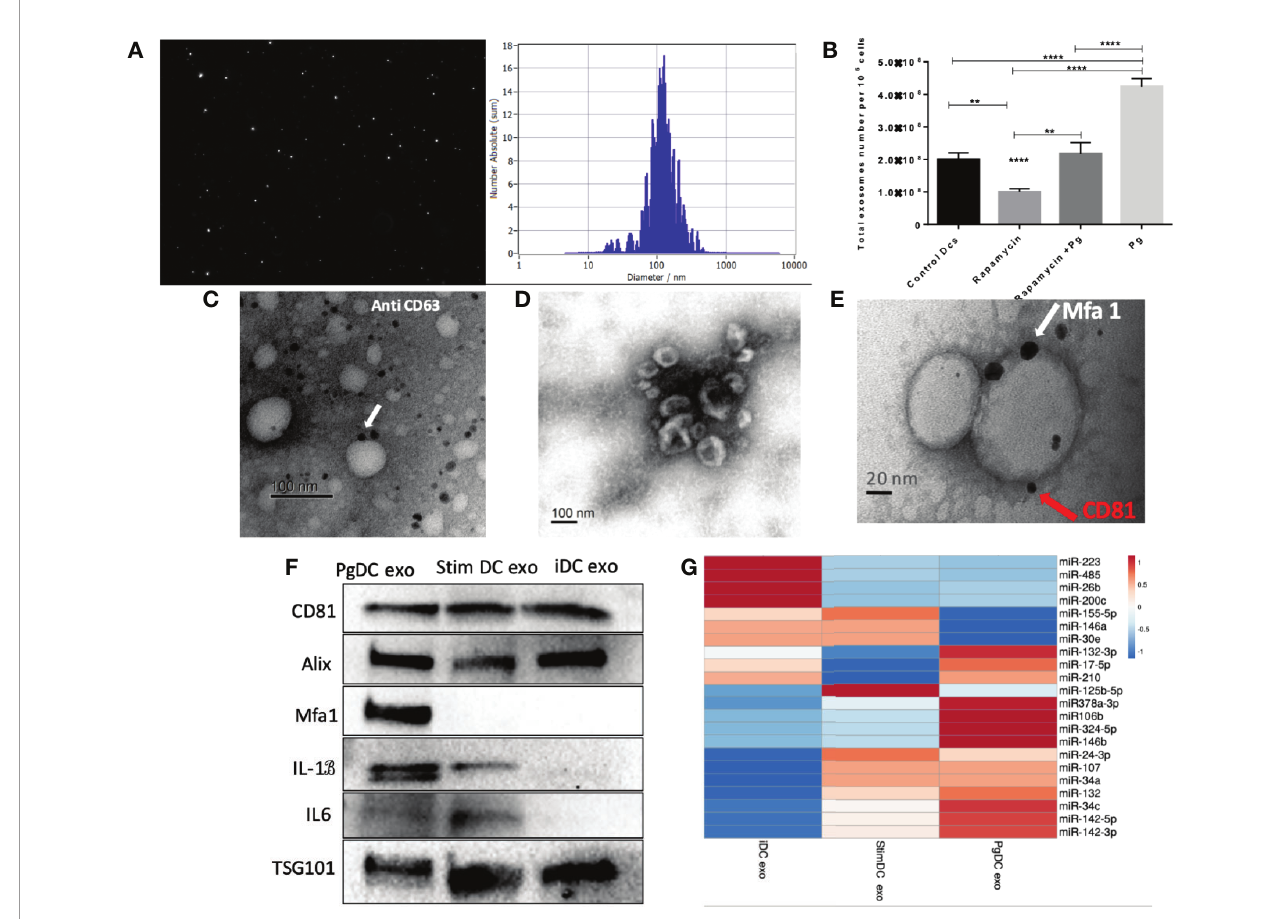
FIGURE 4 | Characterization of exosomes released from DCs infected with P.gingivalis (PgDCexo): (A) Nano tracking analysis (NTA) to determine Exo number and size distribution in nanometer (nm). (B) Total number of Exo released per 10 6 cells as determined by NTA from DCs treated or non-treated with Pg and/or Rapamycin (C) Immuno-gold TEM showing EXO marker, tetraspanin CD63. (D) SEM showing characteristic Exo morphology. (E) Co-localization of Mfa1 bacterial protein (large- sized gold Nano particle indicated with white arrow) with the eukaryotic cellular exosomal marker, CD81 (small-sized gold Nano particle indicated with red arrow) using TEM immune-gold double labeling (F) Western blot showing Exo-related markers TSG101, Alix, and tetraspanin CD81 and proin fl ammatory cytokines IL6, TNFa and IL-1b and Mfa1 in exosomes released from control immature DCs (iDCs), Ecoli LPS-stimulated mature DCs (StimDCexo) and Pg infected DCs (PgDCexo). (G) miRNA analysis of Pg or Ecoli LPS-induced DCs Exo (PgDC exo and StimDCexo respectively) compared to immature control DCs exo; (iDCexo). (iDCs), control immature DCs exo, (StimDCexo), Ecoli LPS-stimulated mature DCs exo; (PgDCexo), Pg-infected DCs. **p<0.01, ****p<0.001, 1 Way